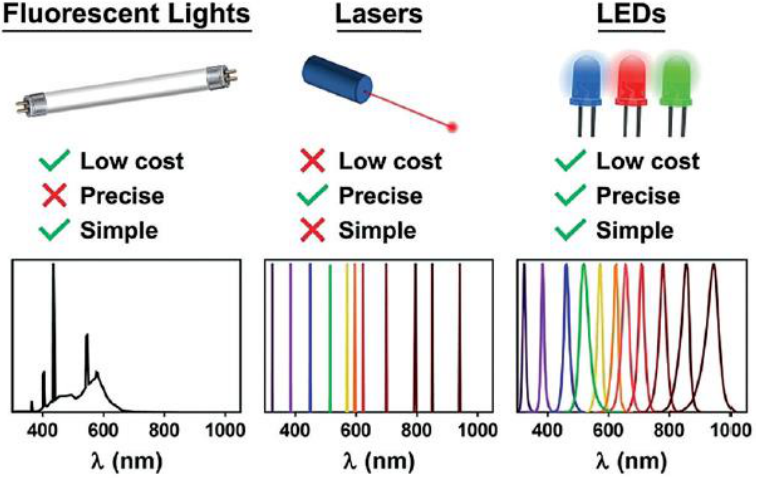
Figure 5. Main advantages of LED light sources. Reproduced with permission from ref. [50].